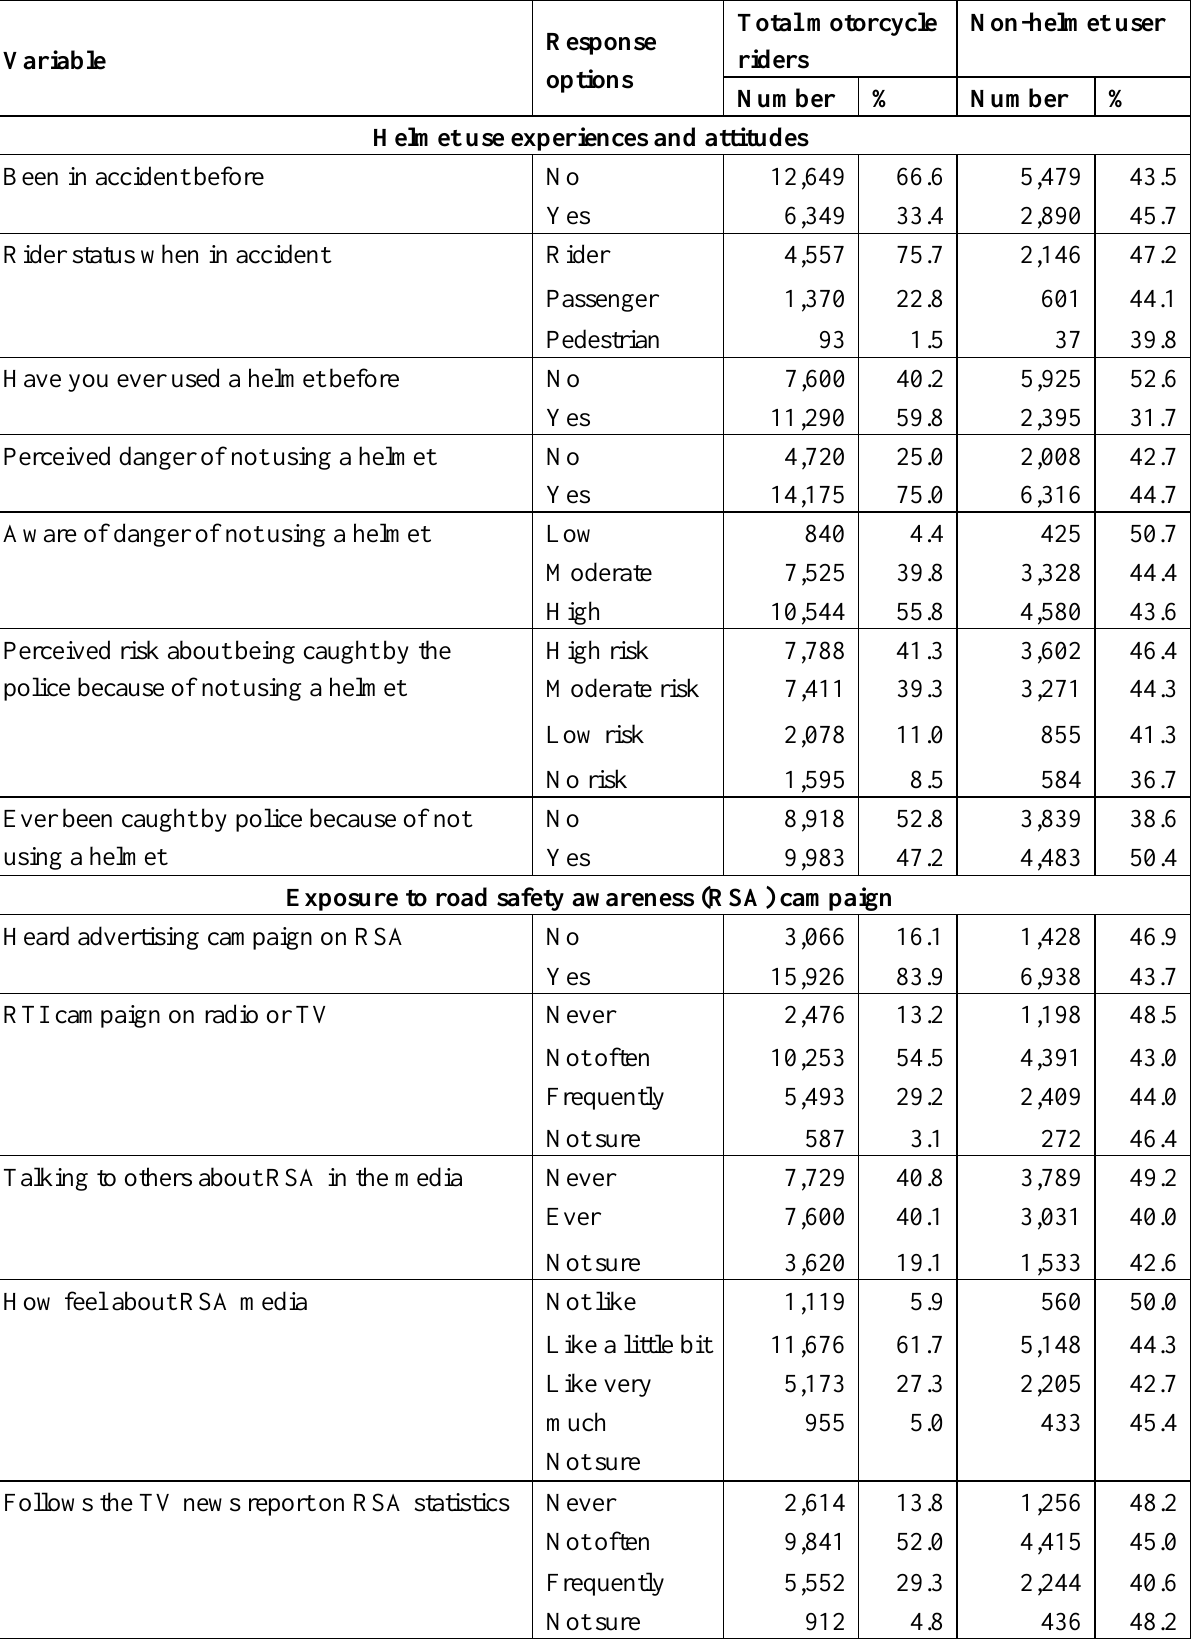
Table 2. Helmet use experiences and attitudes and exposure to road safety awareness campaign of motorcyclists (during Songkran festival) (N = 18,998).